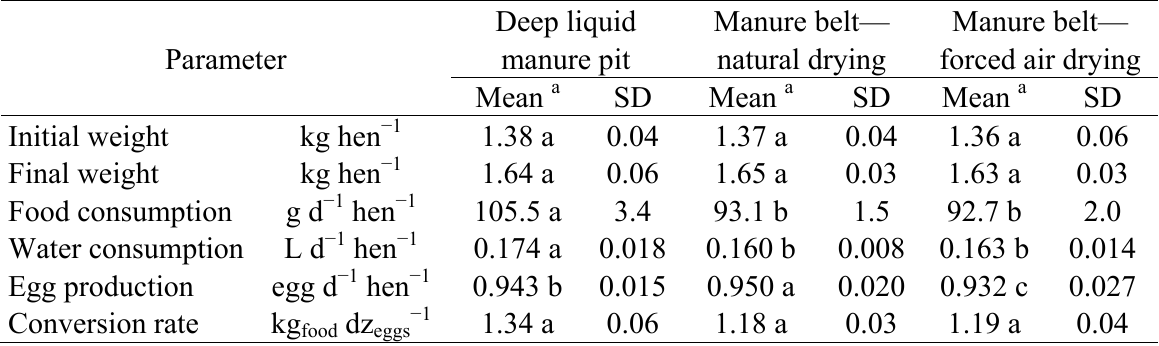
Table 2. Performance of the laying hens in the three housing